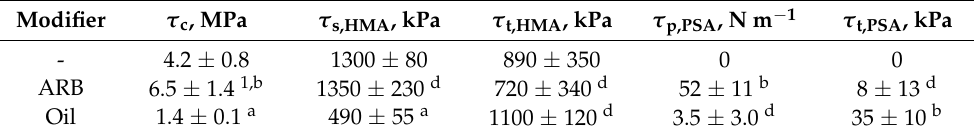
Table 1. Strength and adhesion characteristics of styrene-isoprene-styrene triblock copolymer and its binary mixtures containing 40 wt% of naphthenic oil or asphaltene/resin blend